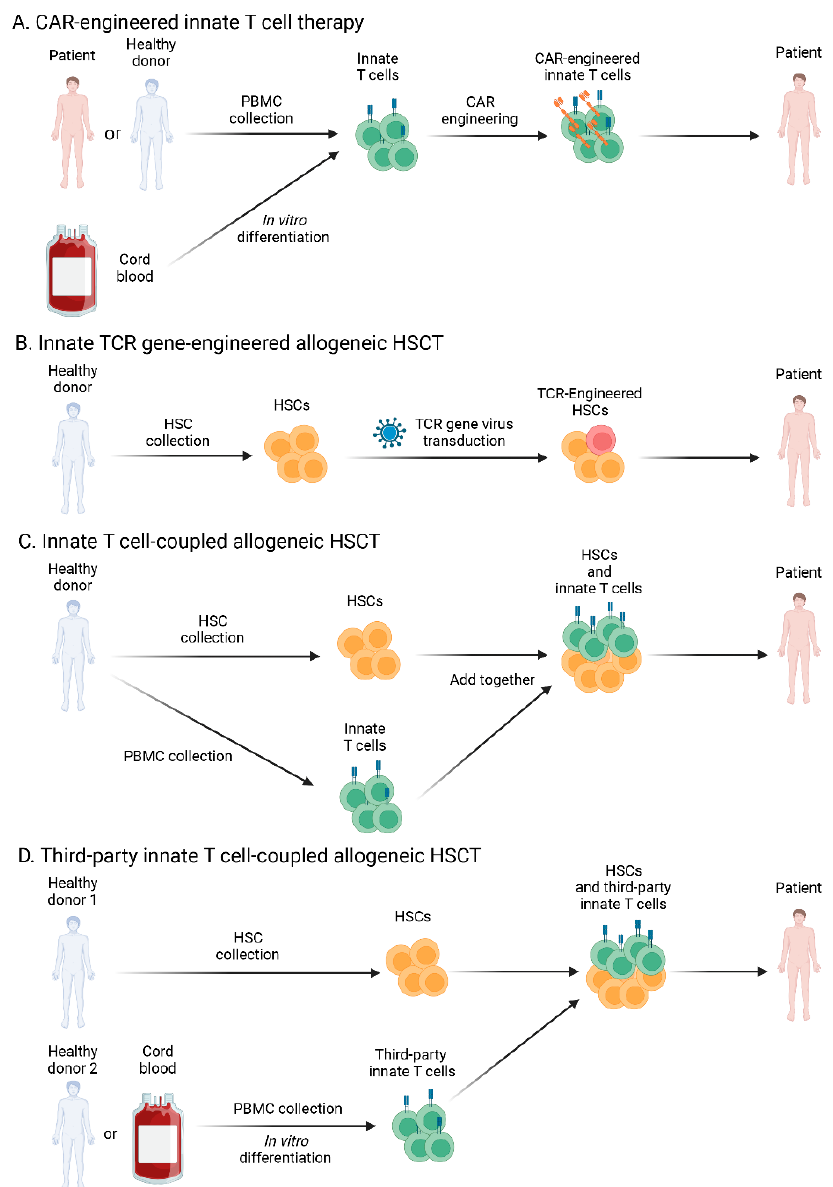
Figure 2. GvHD modulation of innate T cells in cancer immunotherapy. ( A ) CAR-engineered innate T cells are generated from human peripheral blood mononuclear cells (PBMCs) or cord blood hematopoietic stem cells (HSCs). These CAR-engineered innate T cells could target cancers with high efficacy and low GvHD risk. ( B ) Allogeneic HSCs are engineered with innate T cell TCRs via lentiviral or retroviral transduction. Post-transplant reconstitution, innate T cells could be pro- duced continuously to target cancers with reduced GvHD. ( C ) Donor innate T cells are expanded and coupled with HSCs for allogeneic HSC transplantation (HSCT). A low dose of innate T cells could potentially protect patients from GvHD. ( D ) Third-party innate T cells are generated from healthy donor PBMCs or cord blood HSCs and infused to cancer patients with allogeneic HSCs. Off-the-shelf innate T cells could provide a more convenient strategy for GvHD reduction.